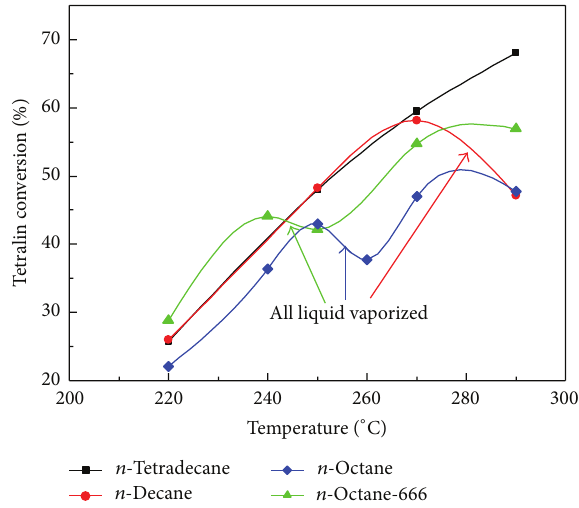
Figure 1: Tetralin conversion versus temperature in different sol- vents. Reaction conditions: 3g catalyst, 5 MPa, 0.3 mL/min tetralin solvent, and H 2 /oil (v/v) = 333 (666 in 𝑛